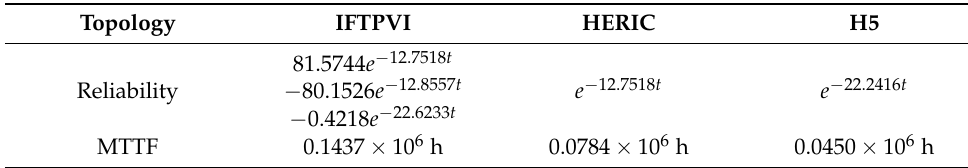
Table 9. Comparison of Fault-Tolerant